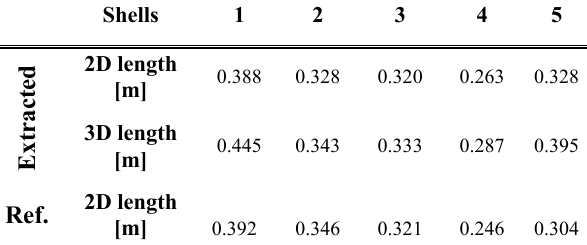
Table 1: Example comparison of 2D vs. 3D lengths from Fig. 6